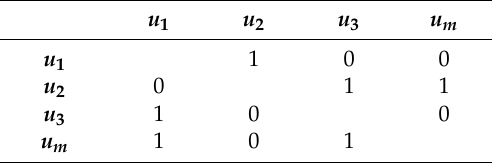
Table 6. The pairwise comparison matrix of an expert.